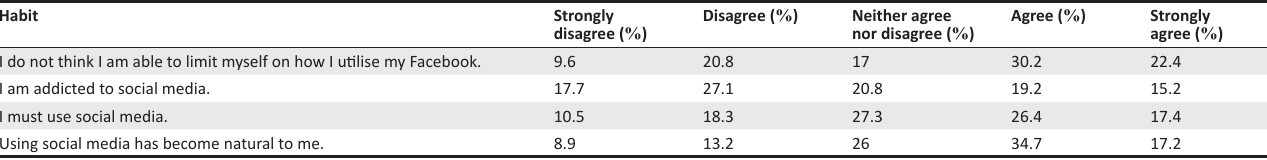
TABLE 3: Habitual social media usage frequencies ( n = 447).